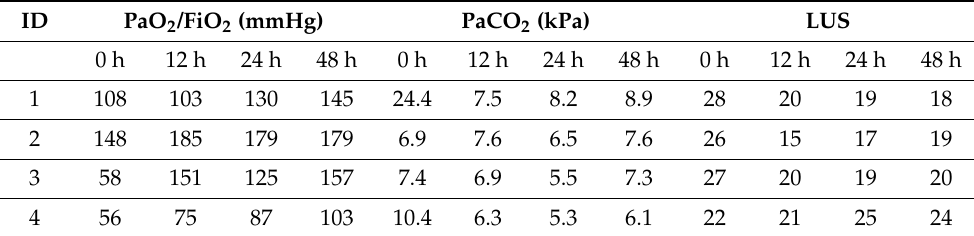
Table 3. The PaO 2 /FiO 2 ratio, PaCO 2 values and LUS score before (0 h), and 12, 24 and 48 h after, the segmental lung recruitment.